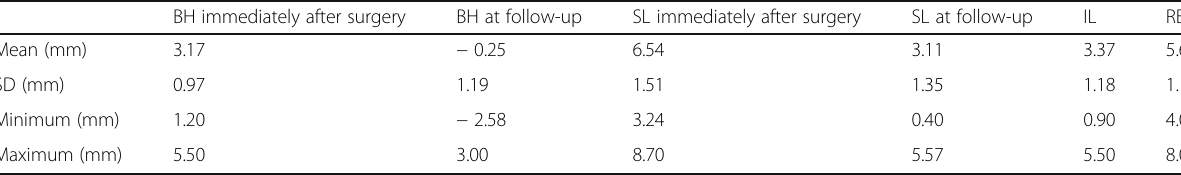
Table 3 Measurement results from CBCT images BH immediately after surgery BH at follow-up SL immediately after surgery SL at follow-up